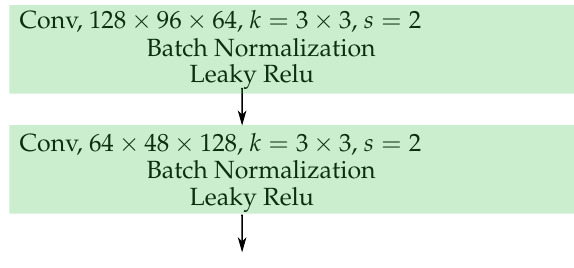
Figure 5. The architecture of the